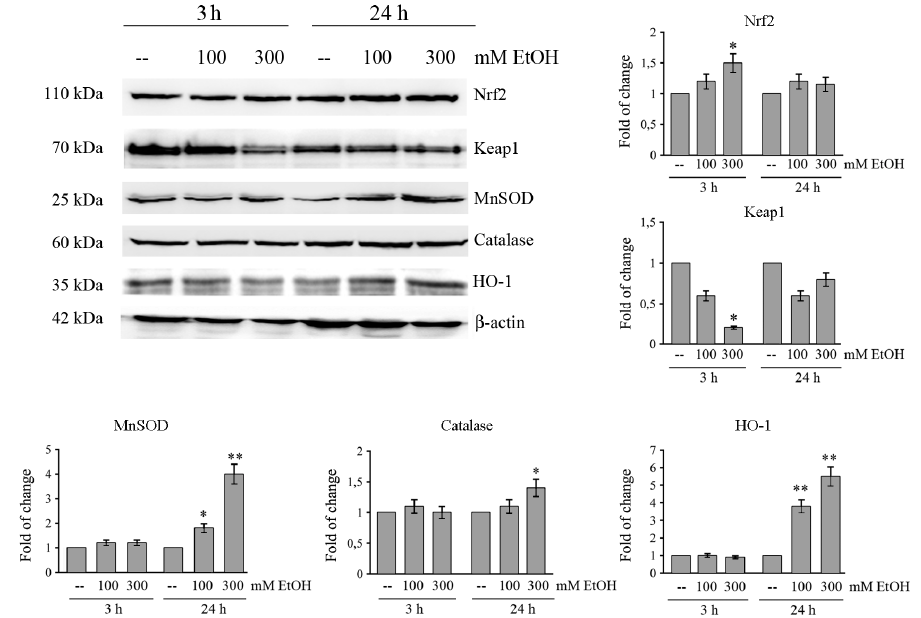
Figure 4. Effects of ethanol on Nrf2-dependent antioxidant pathway in HCT116 cells. Cells (1 × 10 5 ) were incubated in the presence of various doses of EtOH for different periods. The levels of Nrf2, Keap1, MnSOD, catalase, and HO-1 were assessed by Western blotting analysis. Immunoblot was quantified by densitometry and normalized against β -actin expression. Results are from three independent experiments and statistical significance was determined using one-way ANOVA followed by Bonferroni’s test. (*) p < 0.05 and (**) p < 0.01 compared to the untreated sample.